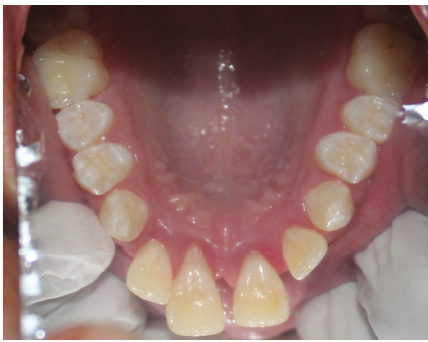
Figure 7: Orthopantomograph of the patient.